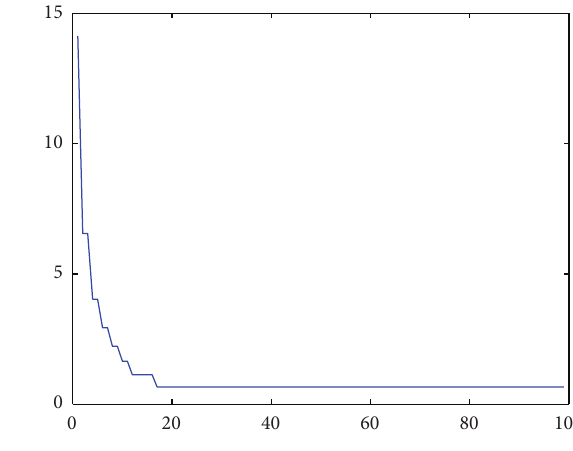
Figure 11: Finial system output trajectory.